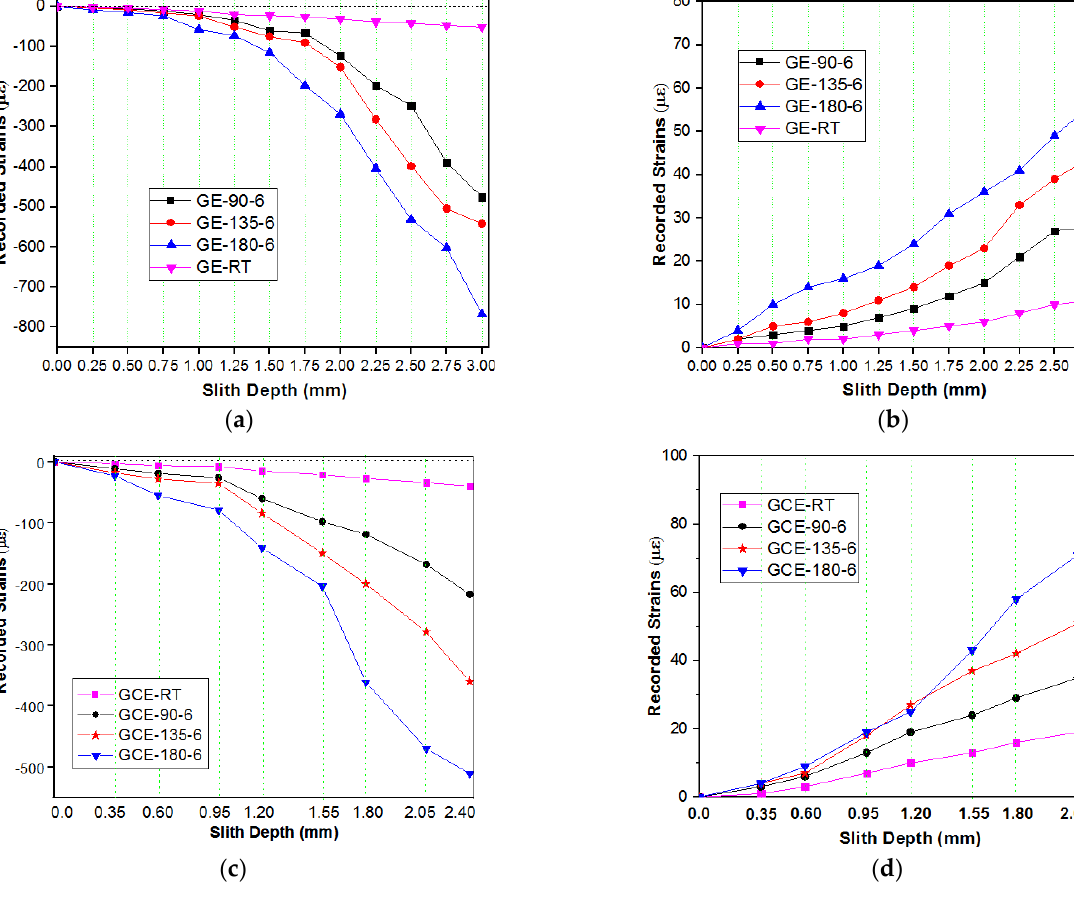
Figure 4. Strains recorded as a function of slit depth ( a ) Longitudinal Strains in each lamina from slitting of GE laminates. ( b ) Transverse strains in each lamina from slitting of GE laminates. ( c ) Longitudinal Strains in each lamina from slitting of GCE laminates. ( d ) Transverse strains in each lamina from slitting of GCE laminates.